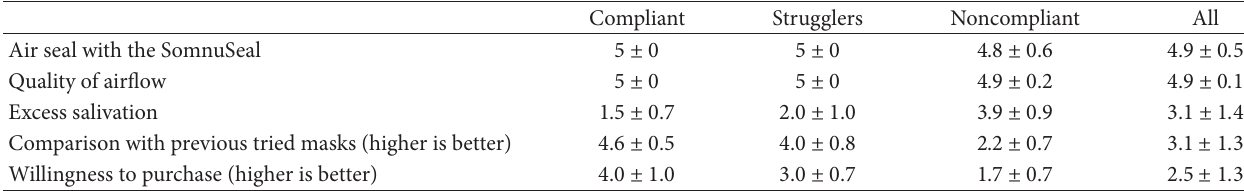
Table 2: Results from the satisfaction questionnaire. In all questions, scale runs between 1 (weak, bad) and 5 (strong, excellent). Compliant